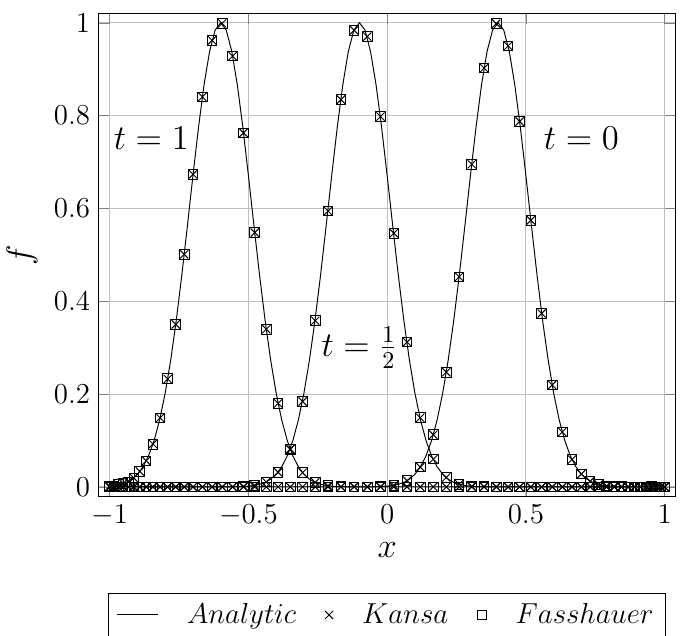
Figure 6. Comparison between Kansa’s and Fasshauer’s approaches at ε = 0.001 for the advection partial differential equation at times t = 0,0.5,1; dt = 0.001; and N = 16. The number of mesh points is fixed at 60 stretched points within the range [ 1,1]. −